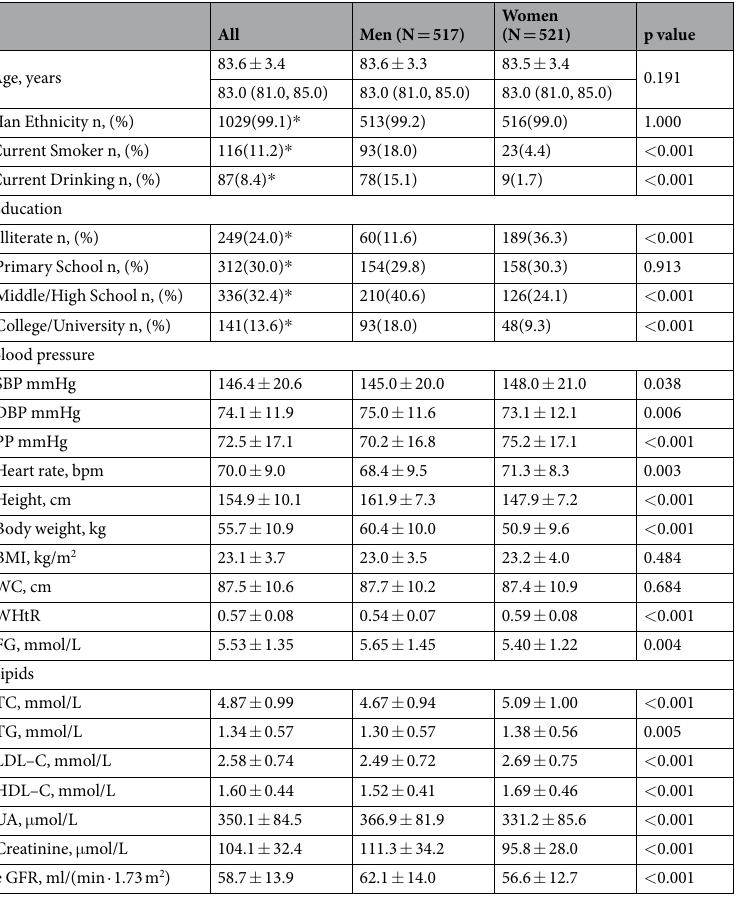
Table 1. Demographic characteristics and cardiovascular risk factors. BMI, body mass index; DBP, diastolic blood pressure; eGFR, estimated goblet filtration rate; FG, fasting glucose; HDL–C, high–density lipoprotein cholesterol; LDL-C, low–density lipoprotein cholesterol; PP, pulse pressure; SBP, systolic blood pressure; TC, total cholesterol; TG, triglycerides; UA, Uric acid; WC, waist circumference; WHtR, waist–to-height ratio. Data are presented as mean ± standard deviation for continuous variables and as frequencies (percentages) for categorical variables, age also presented as median (interquartile). eGFR was calculated according to Cockcroft- Gault equation. * Prevalences are standardized for age and